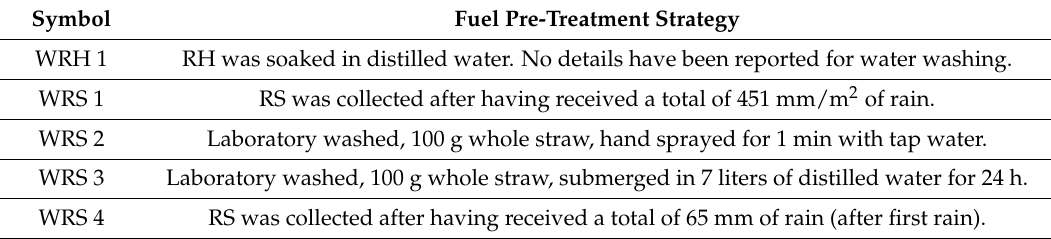
Table 4. Summary of fuel washing strategies for RH and RS used in Figure 4